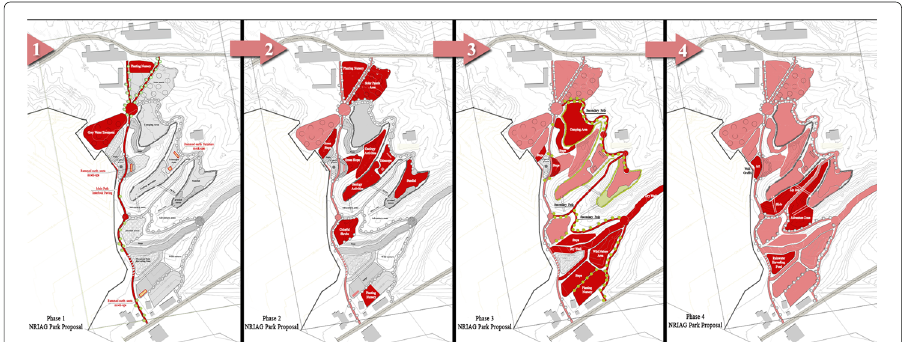
Fig. 4 Recommended phases of